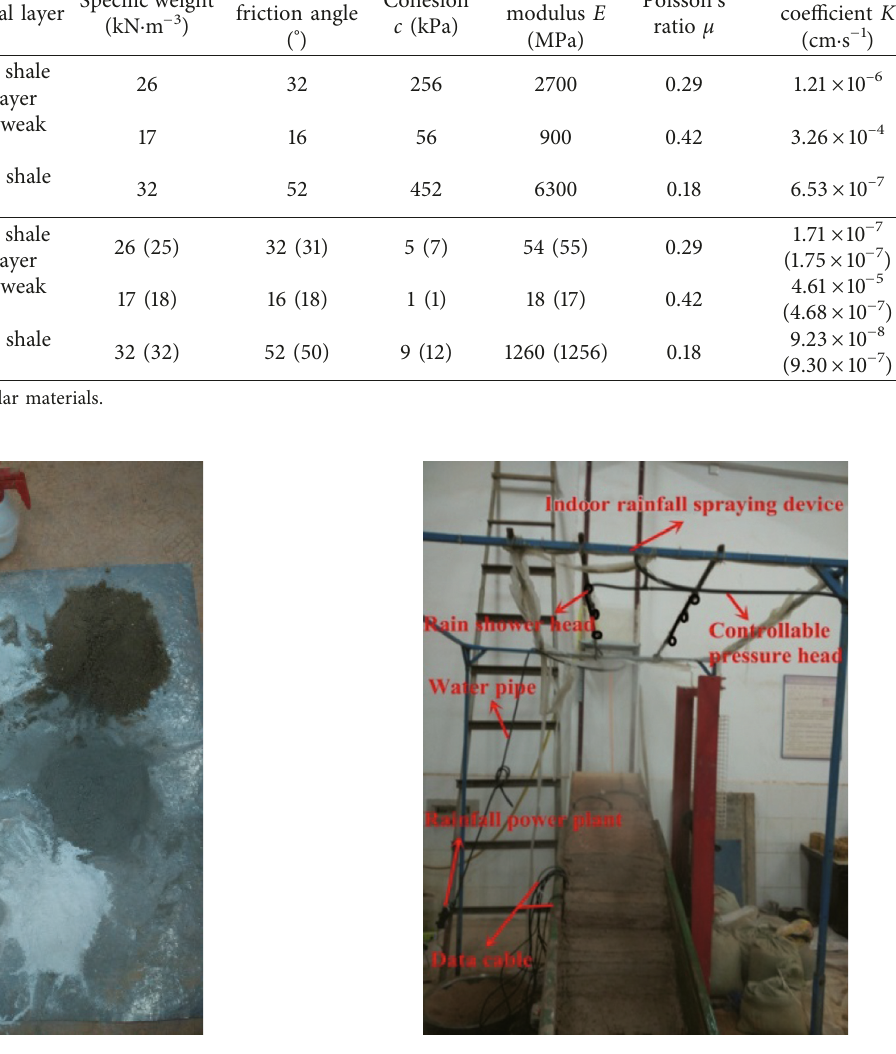
Figure 2: Test raw materials. Figure 3: Indoor rainfall model test